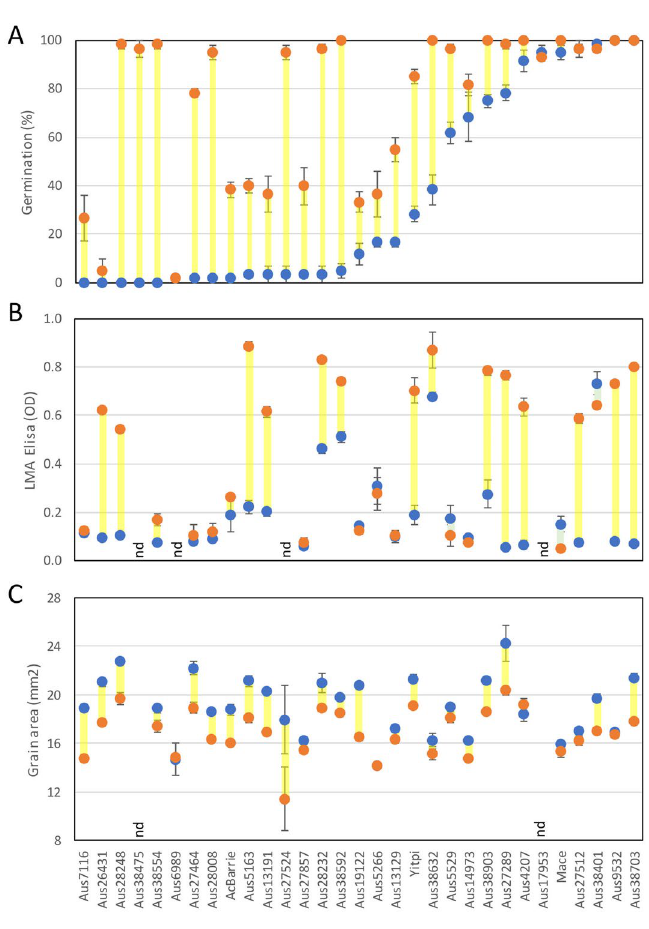
Figure 2. Impact of hot spells on grain dormancy, LMA and grain size. (A) Germination percentage of fresh-harvested samples. (B) LMA expression based on enzymatic assays. (C) Grain size analysis. Blue circles represent the values of the control samples. Orange circles represent heat stressed samples. Yellow lines were added to facilitate the comparison between treatments. Mean values with their SEs are shown. nd: not